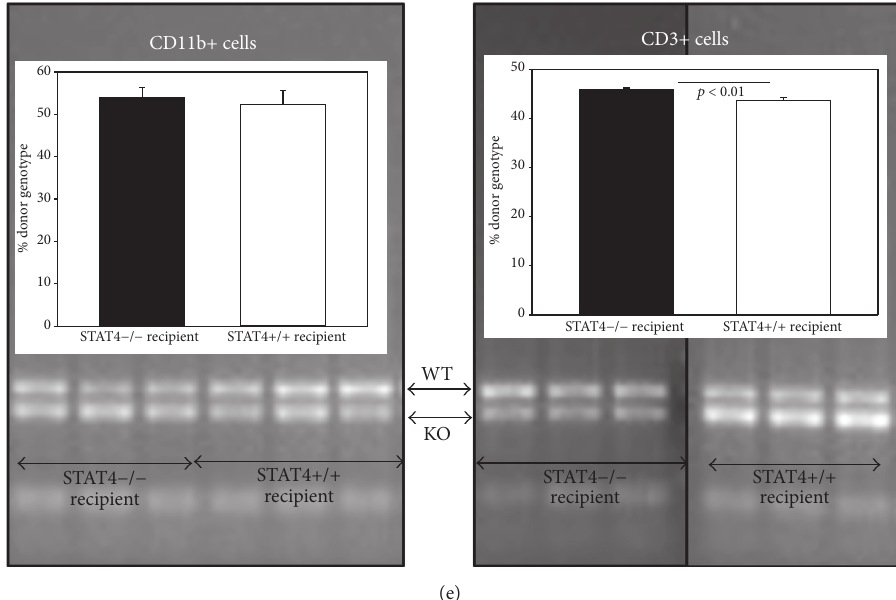
Figure 3: Immune cell composition of the SVF of epididymal adipose tissue of chimeric mice on HFD. (a) SVF was stained with fluorescently labeled anti-mouse CD45, CD3, CD4, and CD8 antibodies and analyzed by flow cytometry. Cell number was calculated based on the corresponding antibody positivity. To determine different T cell subsets, cells in the CD45 positive gate were analyzed. Data represent mean ± SD from 𝑛 = 5 mice/group. (b) Representative plots showing the general strategy for the CD45+ gating and for CD3 positivity and double positivity for CD3CD4 and CD3CD8 within the CD45+ gate of each group. (c) Flow cytometry analysis of SVF stained for macrophage markers CD11b and F4/80 and the APC marker CD11c. Data represents average ± SD of 5 mice. The number of positive cells was determined within the CD45+ gate. (d) Representative immunofluorescent micrographs showing localization of STAT4 (red) and Mac-2 (green) in epididymal adipose tissue of STAT4+/+ mice (i–iii) and STAT4 − / − mice (iv–vi); (vii) shows a crown-like structure containing some cells immunopositive for both Mac-2 and STAT4 (arrows); (viii) shows the nonimmune IgG control; magnification 200x for (i–iii), (iv–vi), and (viii); 400x for (vii). CD11b+ and CD3+ cells were isolated from adipose tissue of chimeric mice by immunoseparation and DNA was extracted and analyzed for presence of STAT4 gene following amplification with specific primers and separation on agarose gels. Band densitometry is also showed and indicates presence of both STAT4-sufficient and STAT4-deficient CD3+ and CD11b+ cells in adipose tissue of both chimeras.